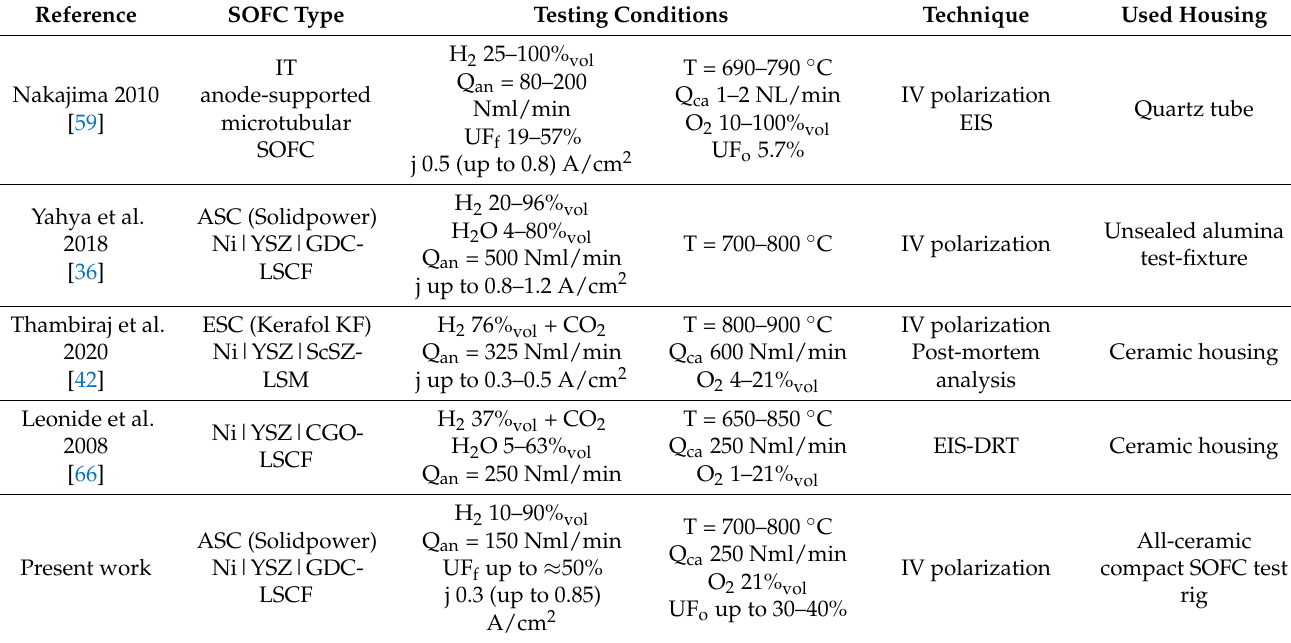
Table 3. Comparative summary (examples) of the analyzed literature respect to the present